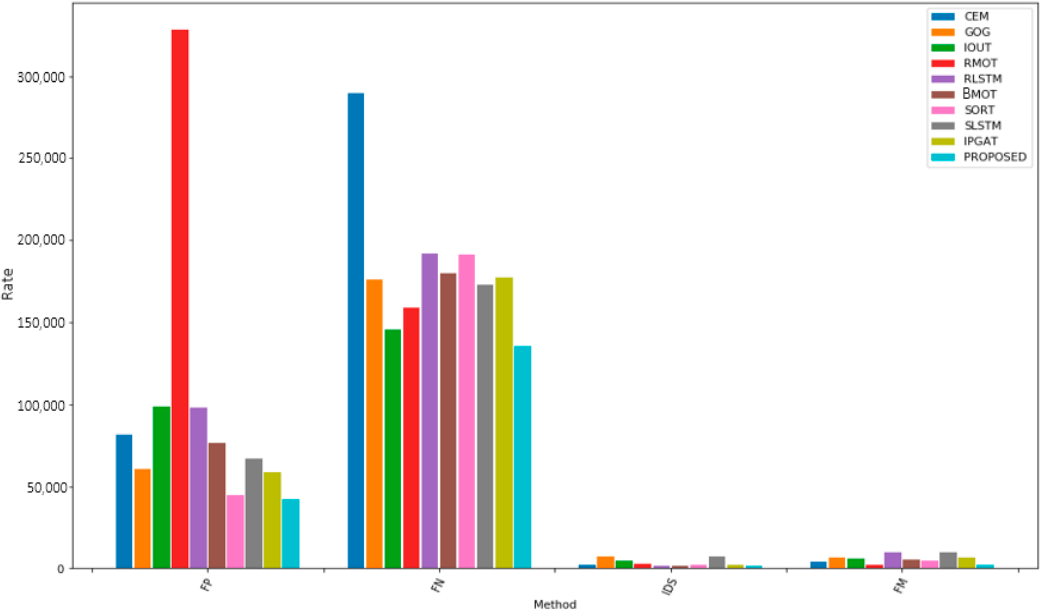
Figure 7. Comparative analysis of proposed method with existing methods. CEM: continuous energy minimization, GOG: global optimal greedy, IOUT: intersection-over-union tracker, RMOT: relative motion online tracking, RLSTM: relative long short term memory, Bayesian multi-object tracking (BMOT), SORT: simple online and real-time tracking, SLSTM: social long short term memory.